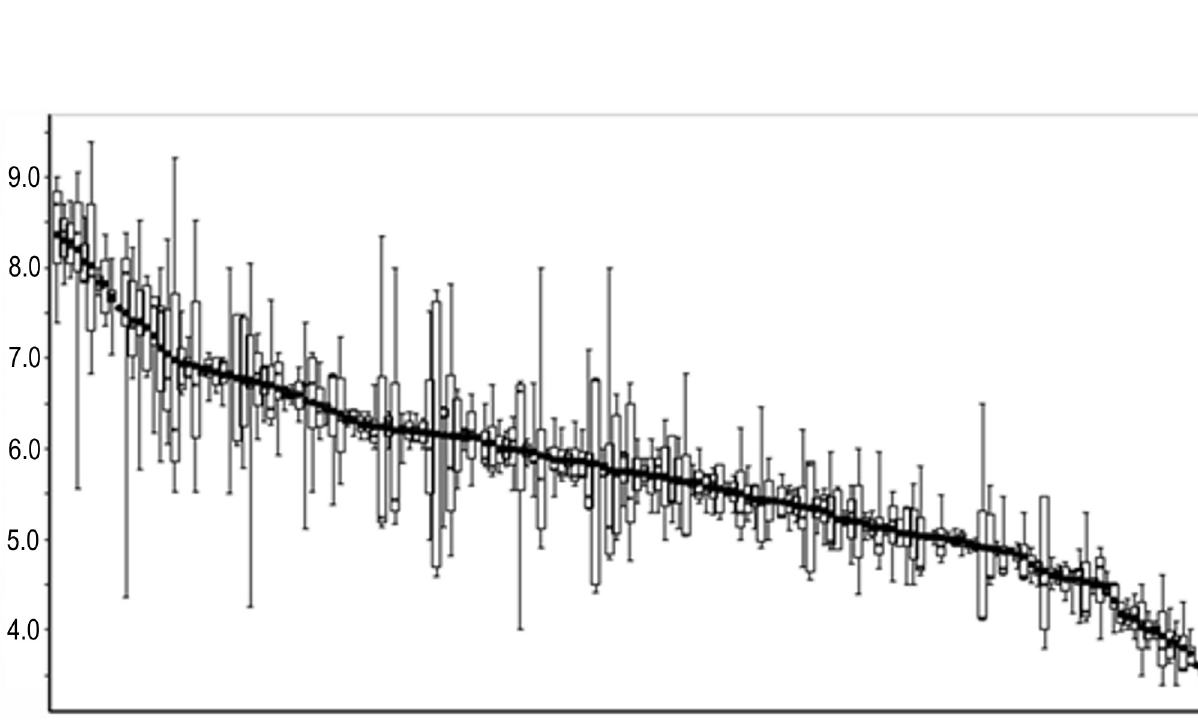
PLOS ONE | https://doi.org/10.1371/journal.pone.0199348 July 6,